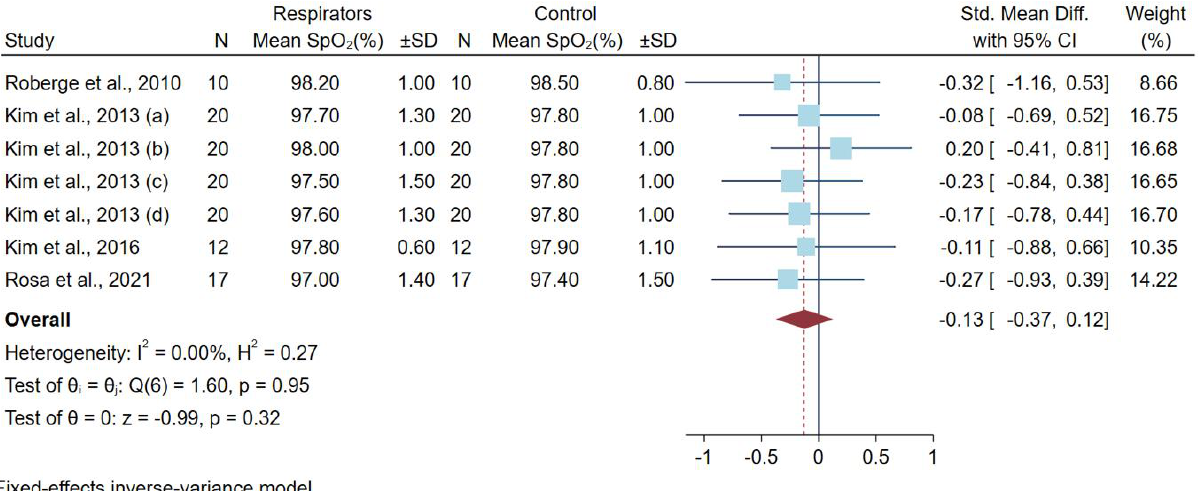
Figure 3. Differences in Oxygen Saturation Levels after a Low-to-Moderate Physical Workload. Abbreviations: CI, confidence interval; SD, standard deviation; SpO 2 , oxygen saturation level; Std. mean diff., standard mean difference [10,14,15,18].